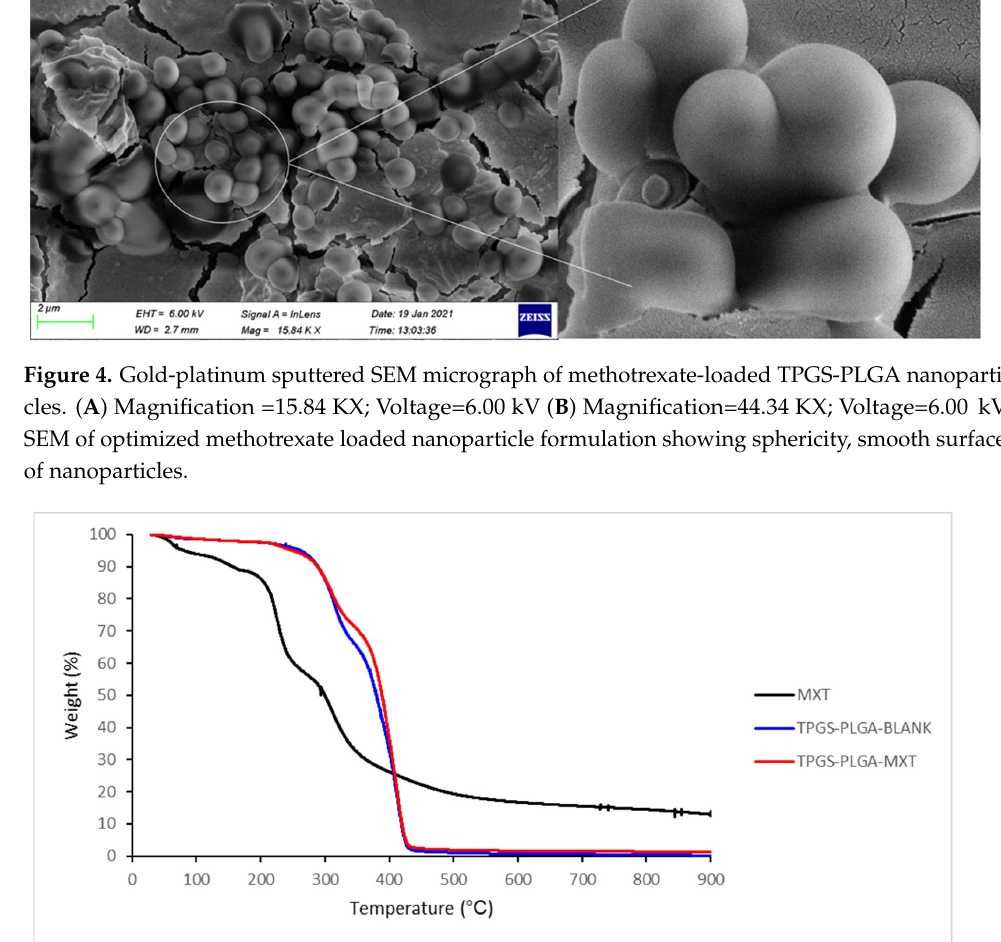
Figure 4. Gold ‐ platinum sputtered SEM micrograph of methotrexate ‐ loaded TPGS ‐ PLGA nanopar ‐ ticles. ( A ) Magnification =15.84 KX; Voltage=6.00 kV ( B ) Magnification=44.34 KX; Voltage=6.00 kV. SEM of optimized methotrexate loaded nanoparticle formulation showing sphericity, smooth sur ‐